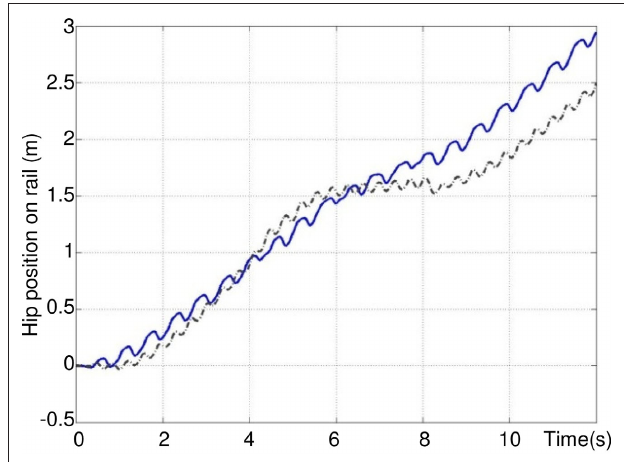
FiguRe 16 | Control of the walking pattern on an uneven terrain for = 10 (dashed black) and σ = 20 (solid blue). At time t = 4 s a vertical up σ s s stair of 7 cm appears (ground is at + 7 cm), at t = 6 s, a vertical down stair of 4 cm appears (ground is at + 3 cm), at t = 8 s, a vertical down stair of 3 cm appears (ground is at 0